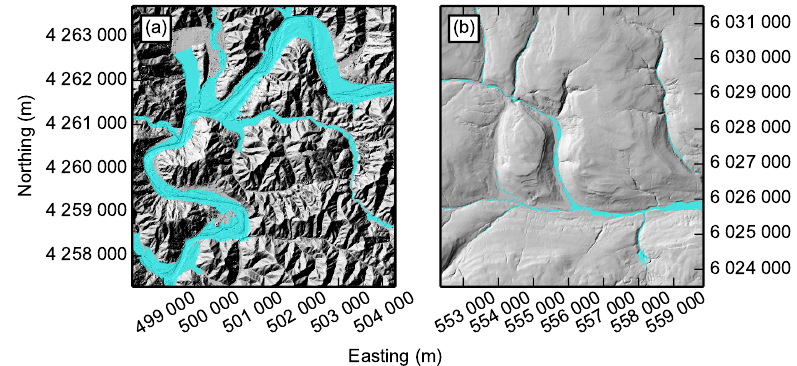
Figure 5. Shaded relief maps showing (a) FEMA flood risk map for the Russian River, CA, UTM Zone 10 ◦ N, and (b) EA flood risk map for the River Swale, UK, UTM Zone 30 ◦ N. In some parts of the landscape the published flood maps do not extend all the way up the catchments.